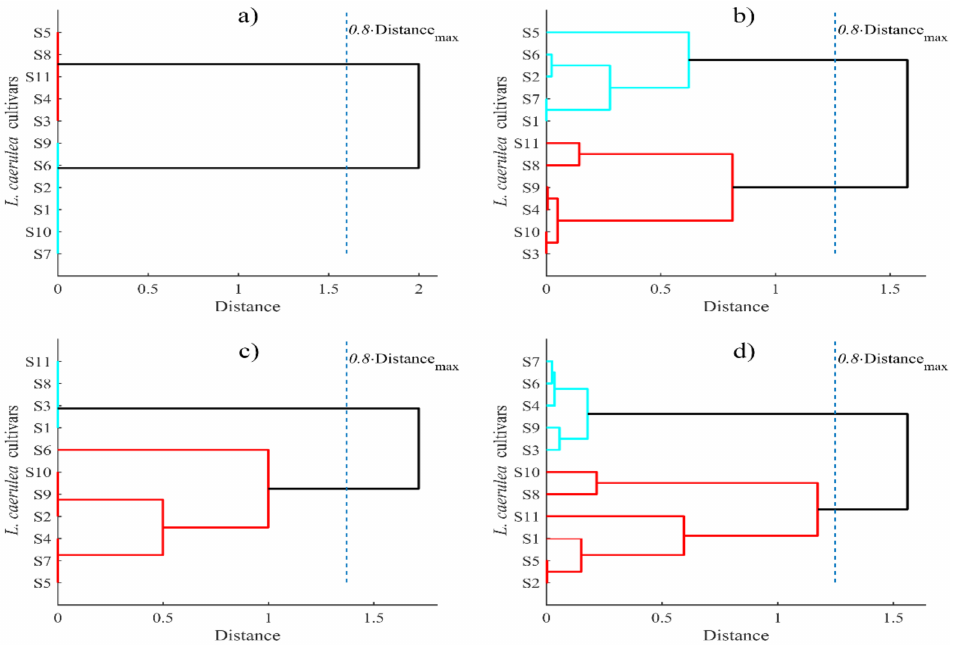
Figure 2. Grouping of Lonicera caerulea cultivars according to the biochemical composition: ( a ) pH and DM; ( b ) total phenolic compounds content, total anthocyanins content, and DPPH radical scavenging activity; ( c ) saccharides; ( d ) organic acids and vitamin C (sample codes are listed in Table 1). 2.2. Total Phenolic Content (TPC), Total Anthocyanin Content (TAC) and Radical Scavenging Capacity (RSC)